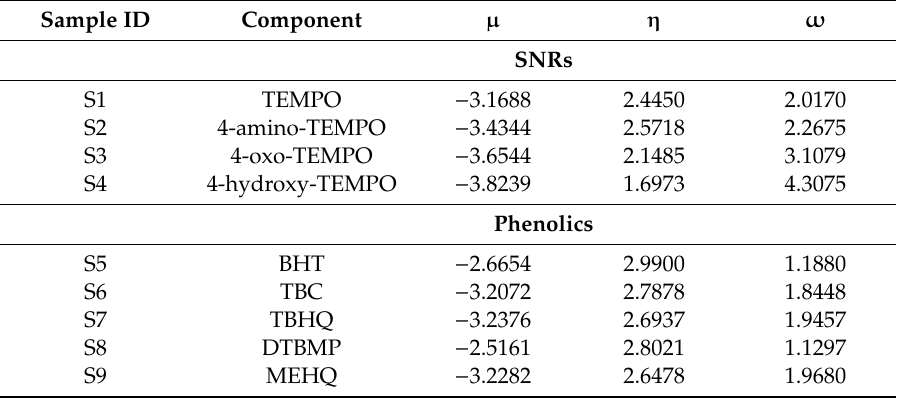
Table 2. Calculated values of µ , η , and ω indexes for SNRs and